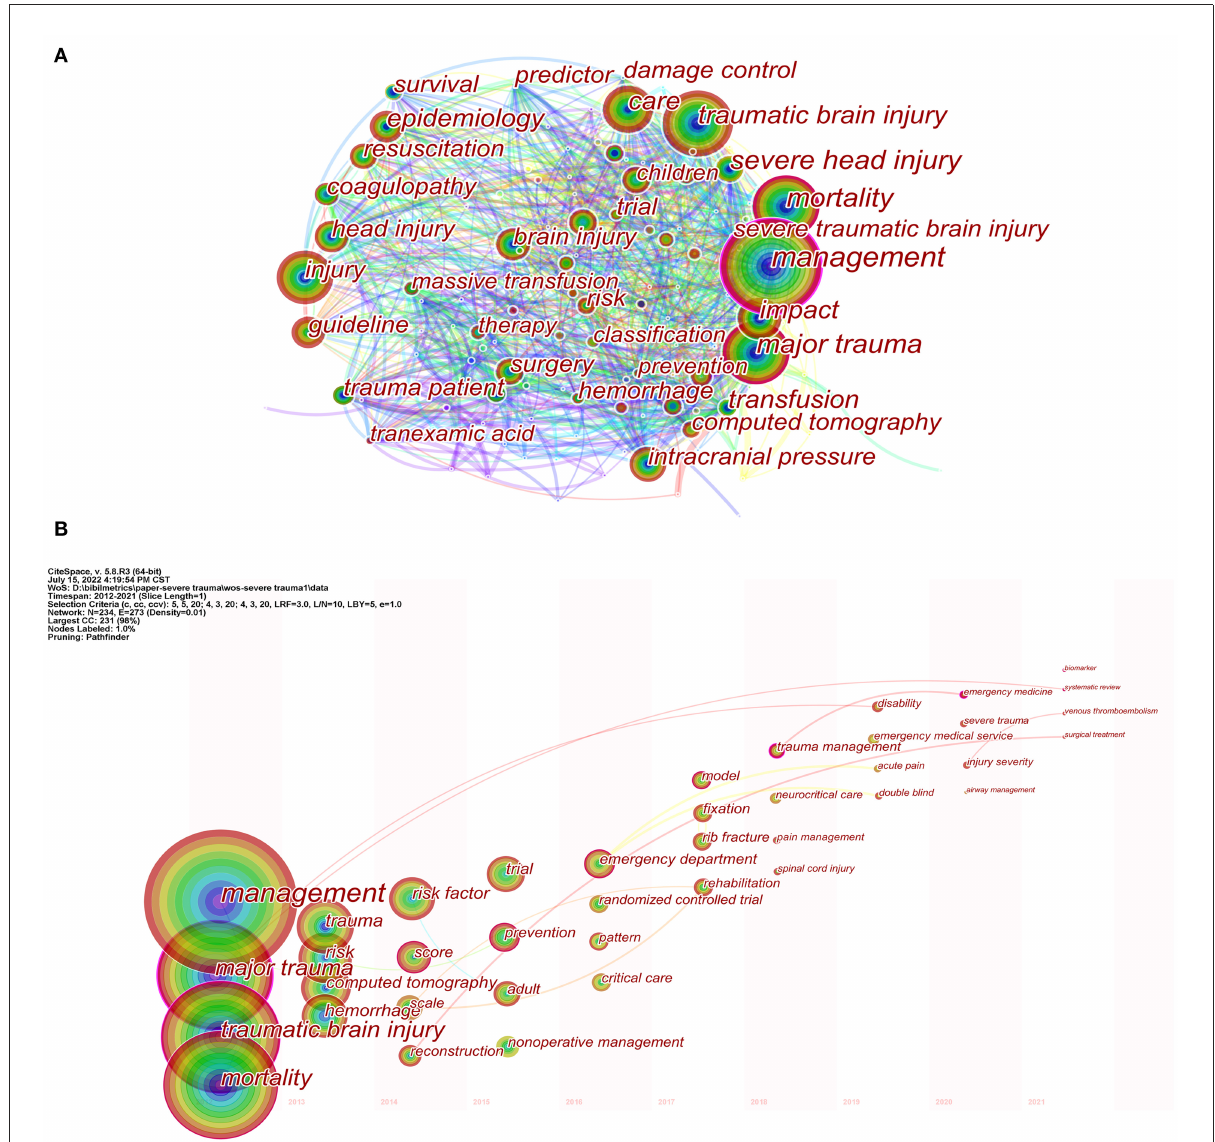
FIGURE8 (A) Keyword co-occurrence network. Different colors of the circles indicate the average year of the studies according to the bar on the lower right corner. (B) Keywords “timezone view” in management of major trauma